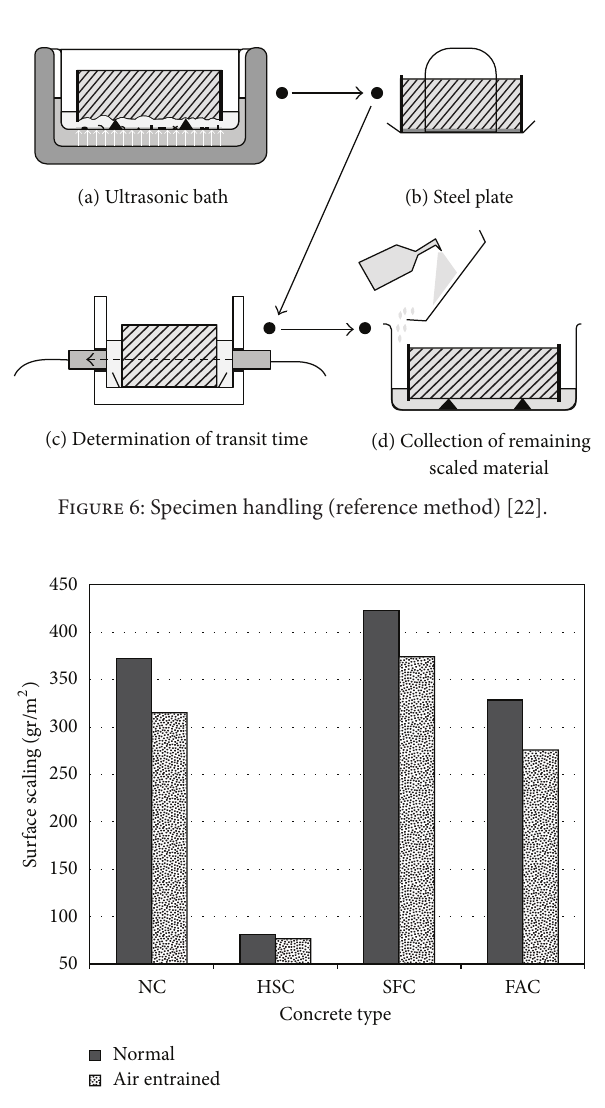
Figure 7: Surface scaling after 28